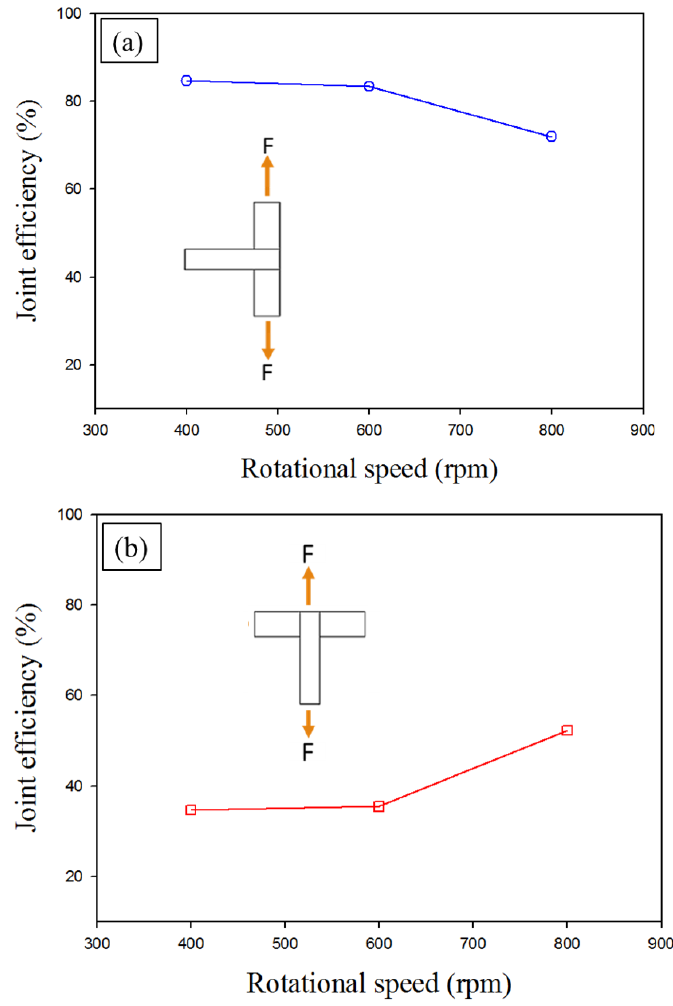
Figure 18. Joint efficiencies against rotational speeds for the T-butt joints of 2024-7075 Al alloys; ( a ) tensile tested along the skin and ( b ) along the stringer directions.